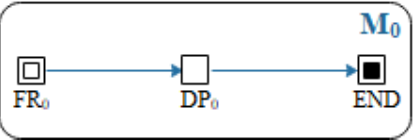
Figure 9. Schematic generation process diagram of FR 0.